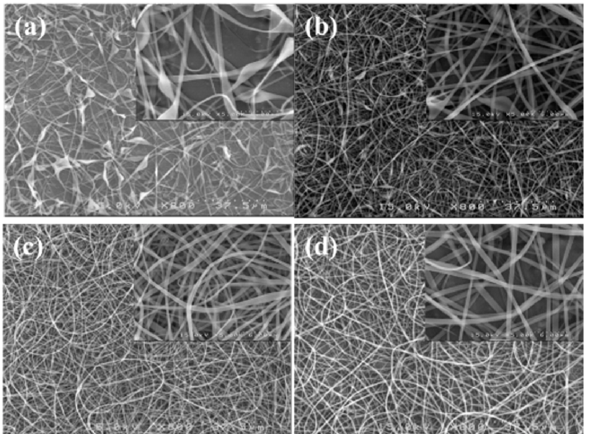
Figure 13. SEM images of fibers electrospun from a-PNIPAM aqueous solutions at different concen- trations of ( a ) 8, ( b ) 9, ( c ) 10, and ( d ) 14 wt%. ( Q = 0.1 mL/h, V = 13 kV, H = 21 cm, T solution = 10 ºC.)